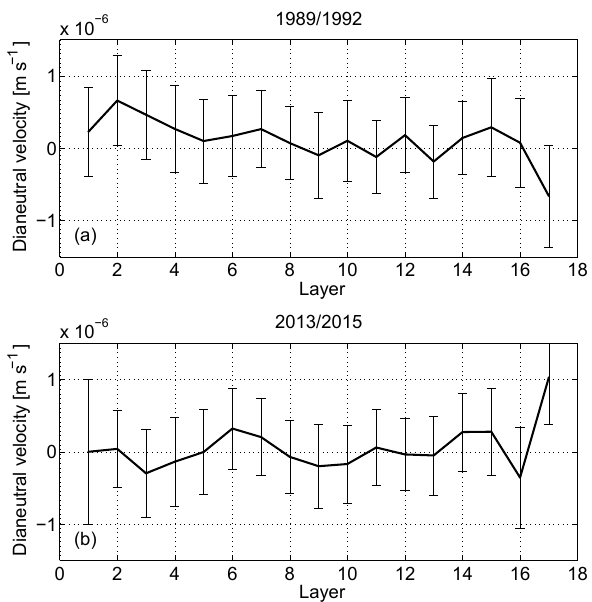
Figure 9. The dianeutral velocity across the layer interfaces be- tween the two sections for the periods of (a) 1989/1992 and (b)